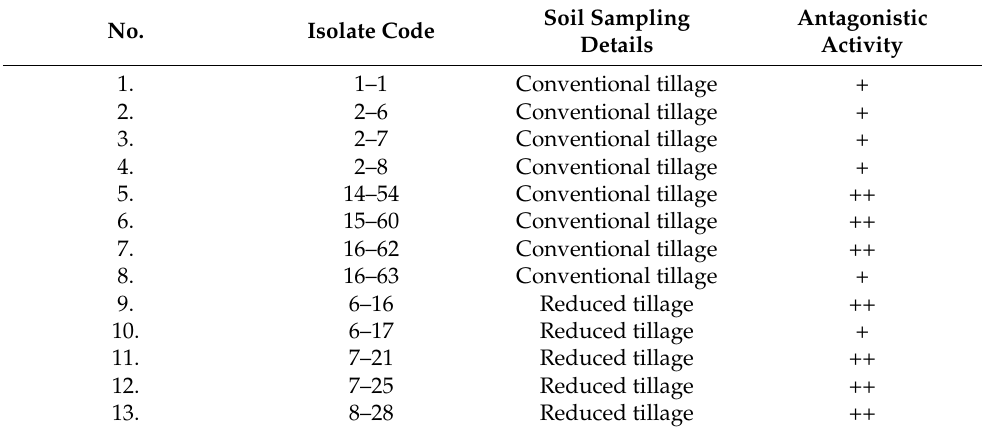
Table 3. Antagonistic activity of soil bacteria against F. graminearum mycelial growth on potato dextrose agar plates.